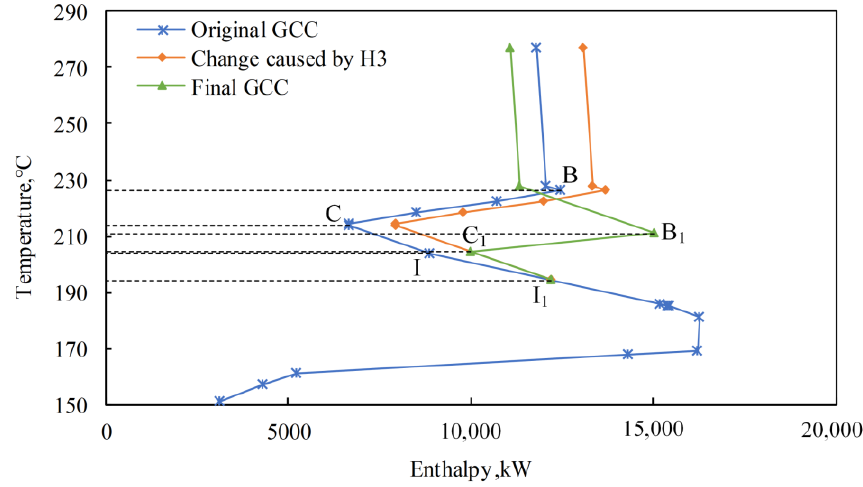
Figure 9. Variation of GCC above the pinch.